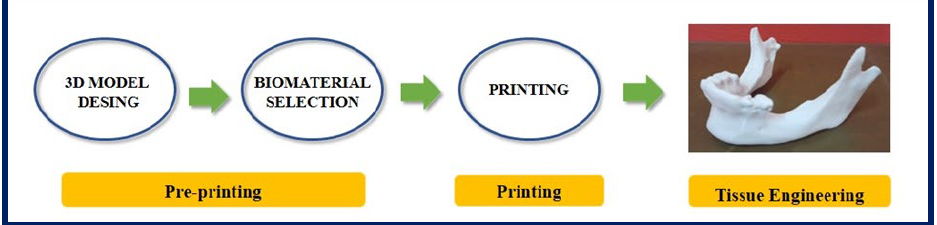
Figure 12. Process of design and manufacture of a jaw by means of 3D printing. Bibliography con- sulted [116].